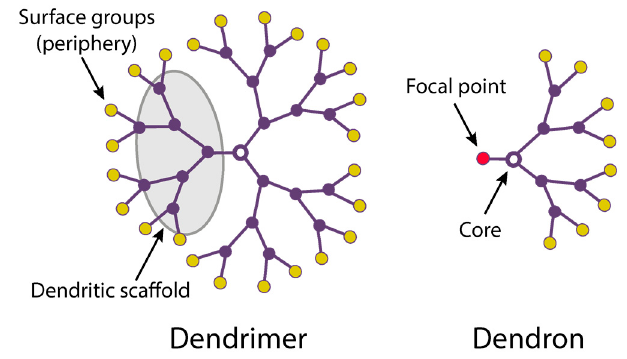
Figure 1. Schematic drawings of a dendrimer and dendron.